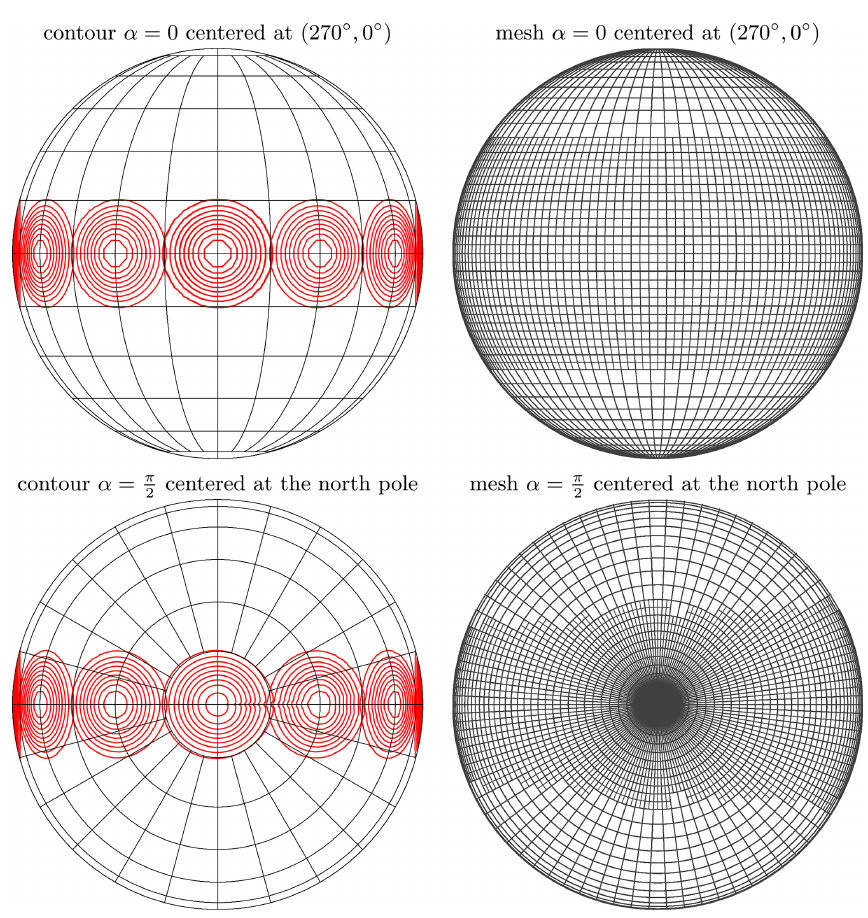
Figure 8. Snapshots of the solid body rotation test case when α = 0 and α = 0 . 5 π at each day with one-level refinement. The coarse mesh has a resolution of 5 ◦ × 5 ◦ , and high-resolution areas have a resolution of 2.5 ◦ × 2.5 ◦